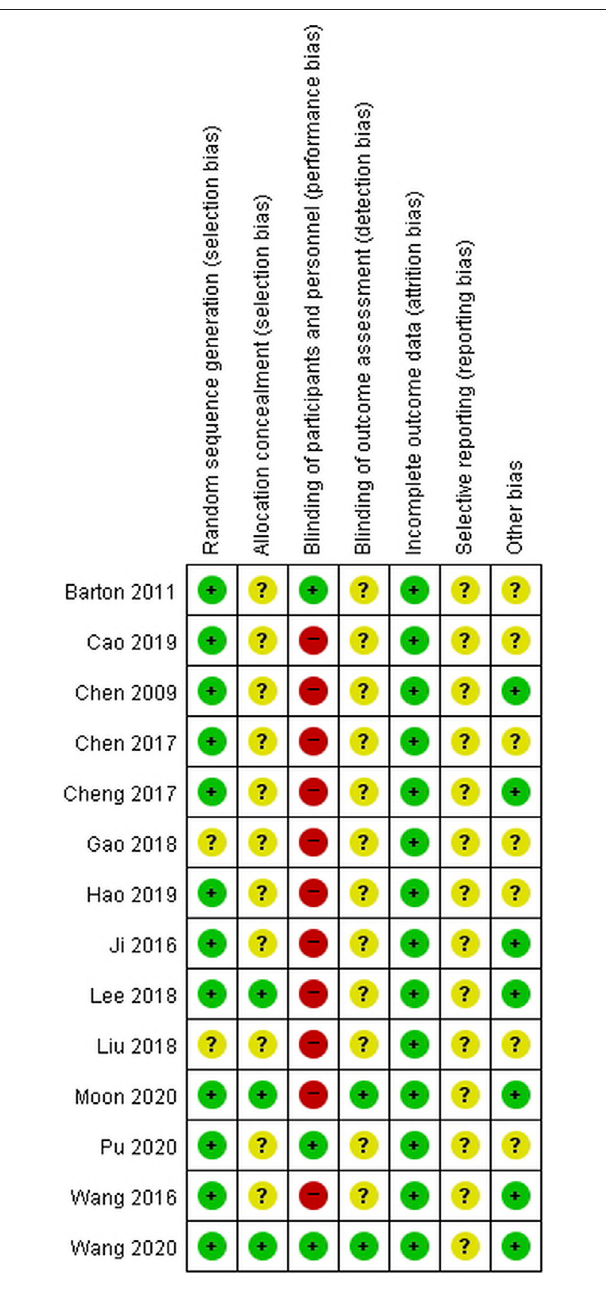
Frontiers in Pharmacology |